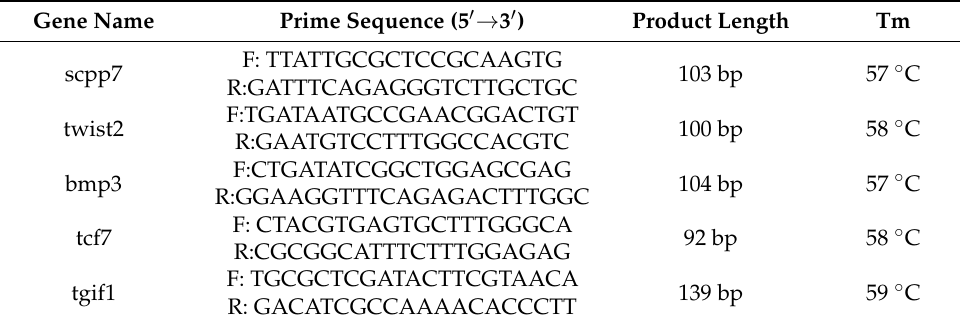
Table 1. Primers used in qPCR